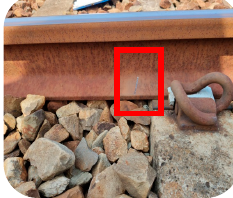
Figure 15. Simulated rail break on bottom in side ‐ view. Table 21. Side ‐ view defect inspection by AI and human.